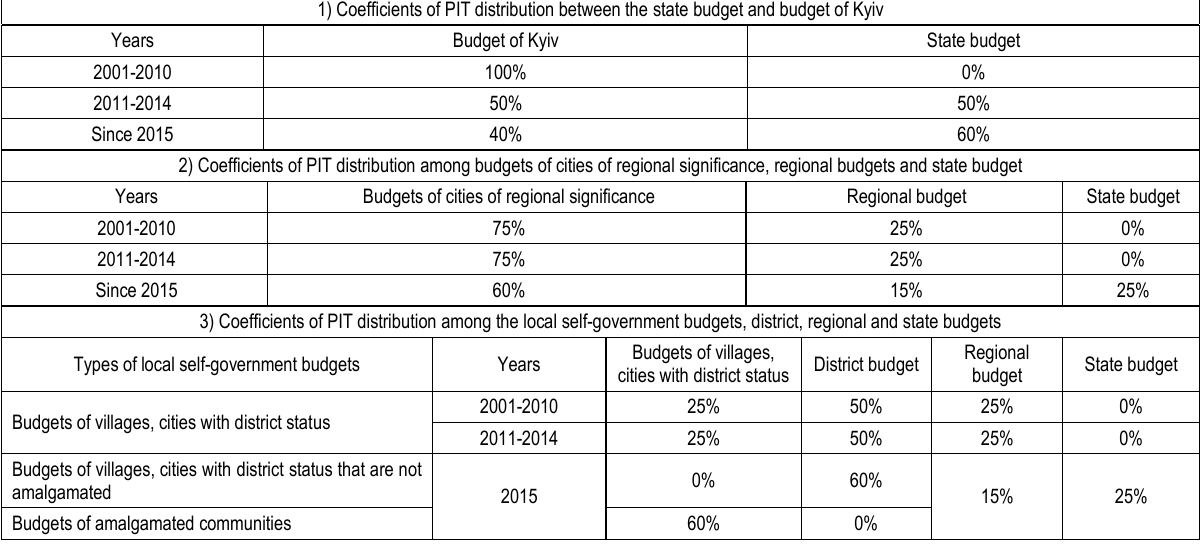
Table 1. Changes in the percentage of PIT distribution among the state and local budgets 1) Coefficients of PIT distribution between the state budget and budget of Kyiv